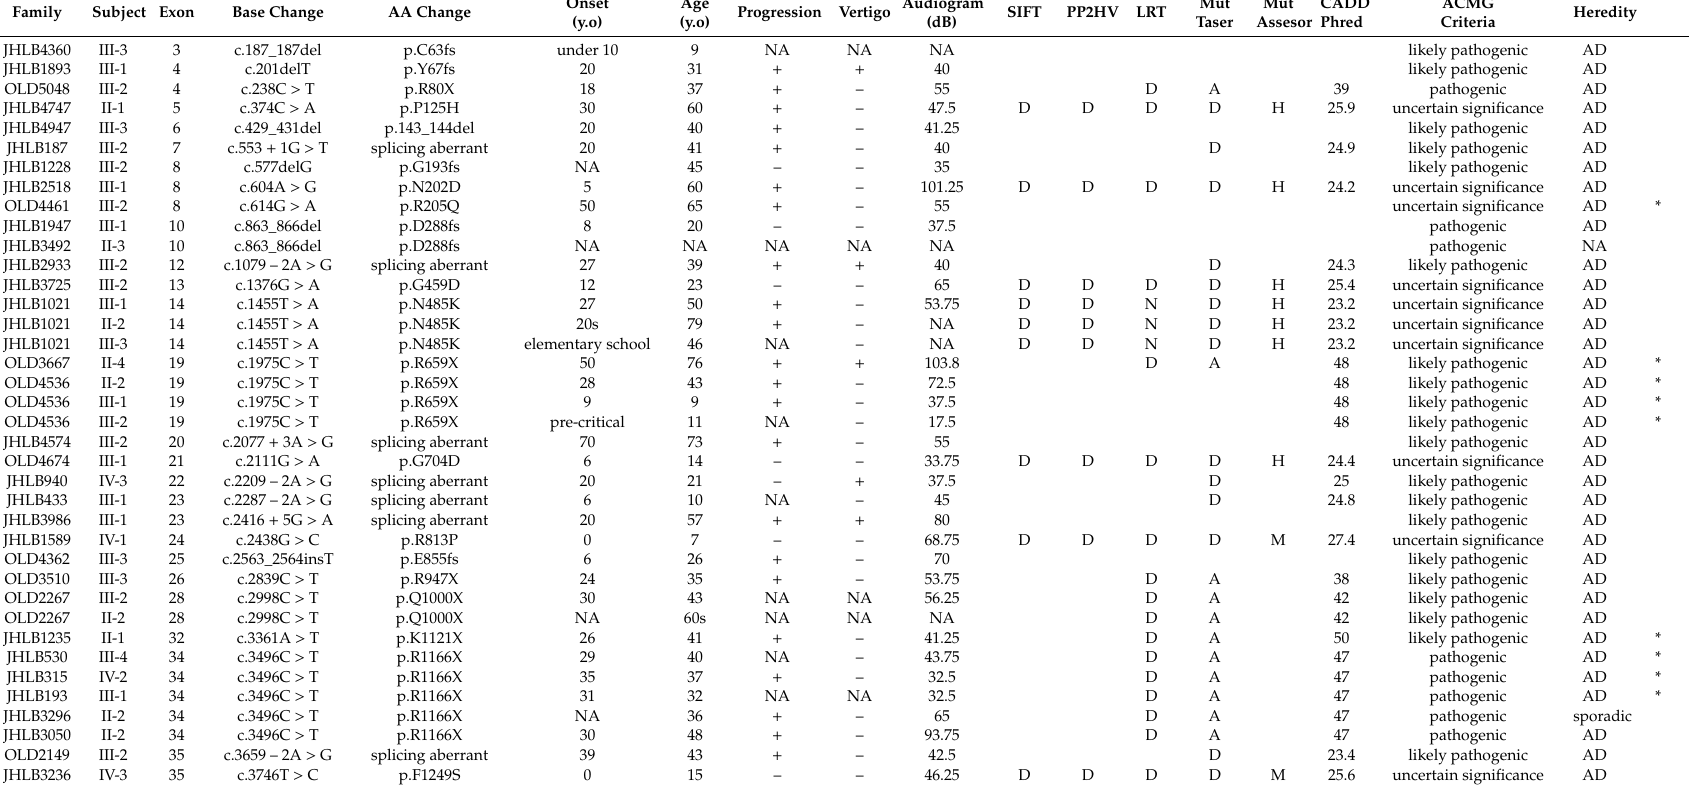
Table 1. Possibly disease-causing MYO6 candidate